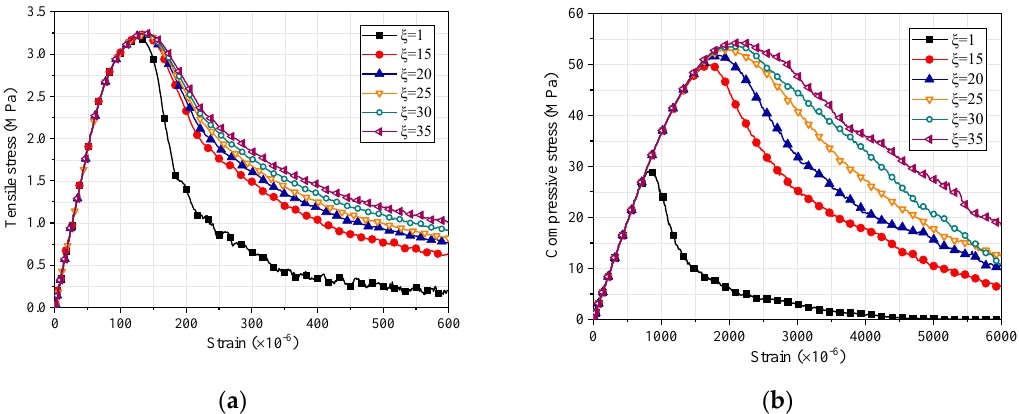
Figure 16. Effect of mode II fracture energy on global stress-strain relationship under tension ( a ) and compression ( b ).